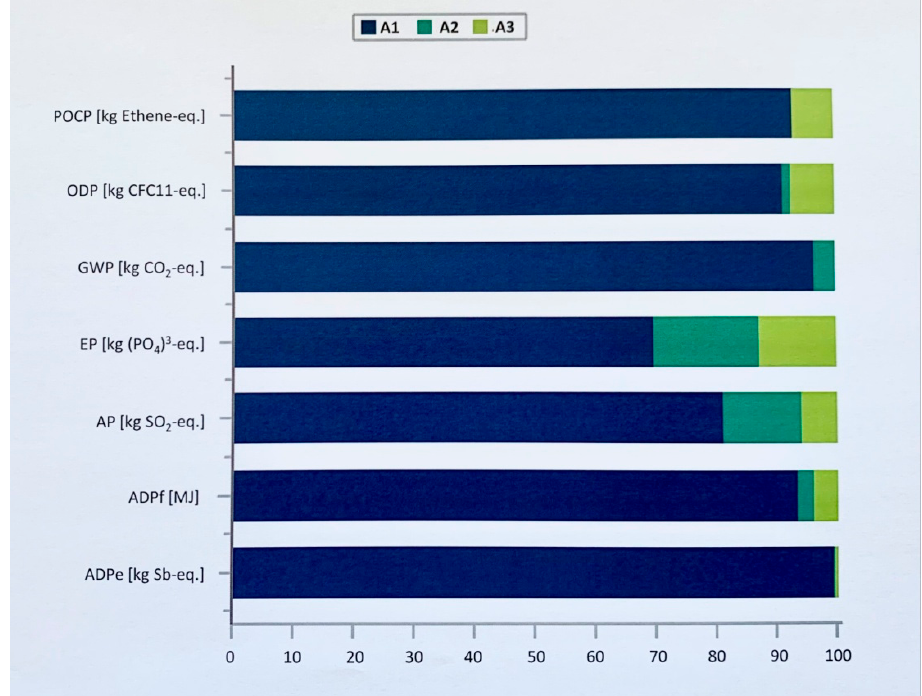
Figure 8. Relative contribution (%) of each life cycle stage, A1, A2 and A3 (raw materials supply, transport and manufacturing, respectively) to different environmental indicators for 85% HRC product. Table 6. Relative contribution of environmental impact indicators between 85% HRC spray-dried powder production and an average traditional spray-dried powder production, as a percentage of the overall contribution of the A1, A2, A3 manufacturing process (raw materials supply, transport and manufacturing, respectively).